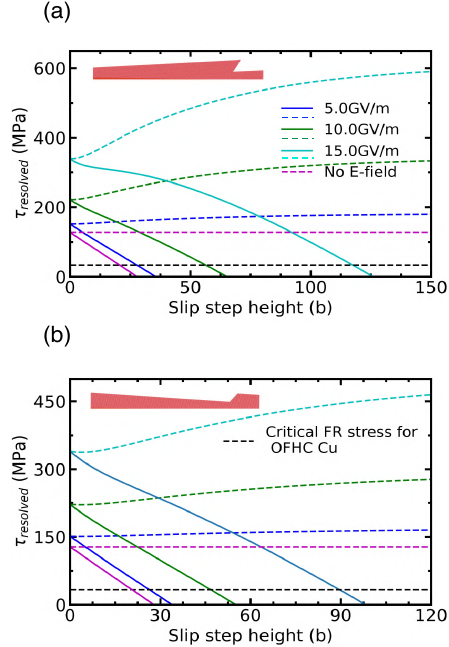
FIG. 6. Stress (RSS) enhancement and relaxation for steps A (a) and B (b) for FR sources located at a depth of 20 nm from the surface as computed for typical OFHC Cu microstructural parameters listed in Table II. Solid lines correspond to constant volume cases when thermal stresses can relax, while dashed lines represent growth of RSS when at a fixed thermal stress for heating at 80 °C.